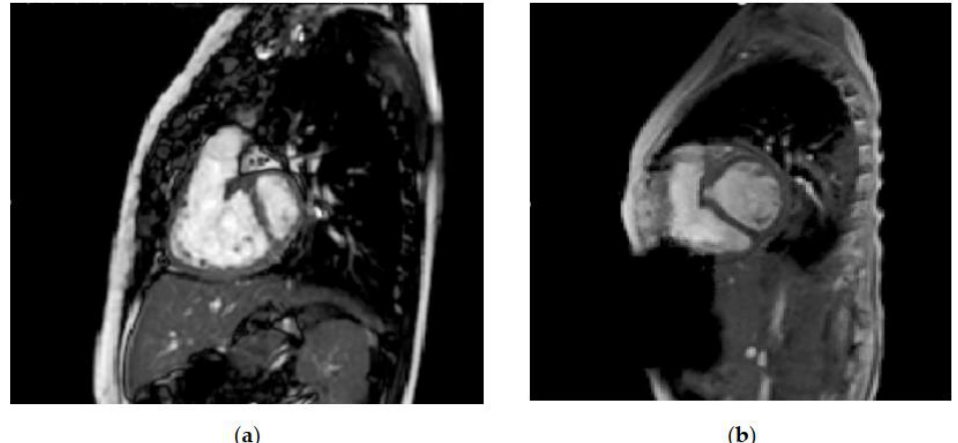
Figure 2. Comparison of left ventricular volumes on magnetic resonance imaging ( a ) before left ventricular recruitment: left ventricular end-diastolic volume (LVEDV) 12.9 mL, indexed left ventricular end-diastolic volume (LVEDVi) 20.2 mL/m 2 and ( b ) after full biventricular conversion: LVEDV 54 mL and LVEDVi 72 mL/m 2 .